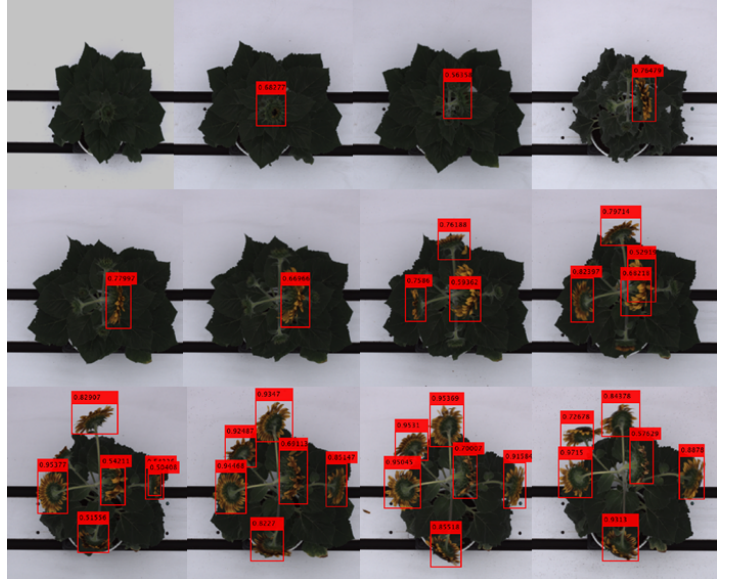
Figure 7. Illustration of flower emergence timing detection using a sample sunflower image sequence (D2) for the top view over consecutive days (following left to right direction) starting from Day 16 ( top-left ) to Day 27 ( bottom-right